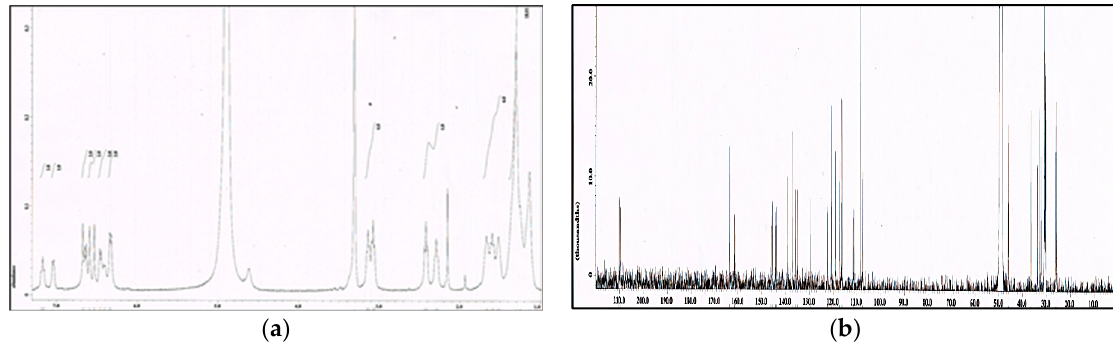
Figure 4. 1 H-NMR ( a ) and 13 C-NMR ( b ) spectra of compound 3 .